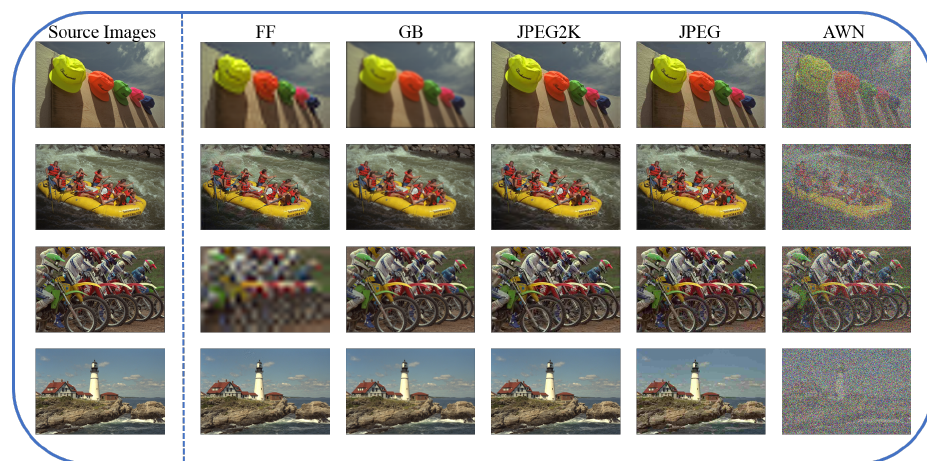
Figure 5. Some samples from the LIVE